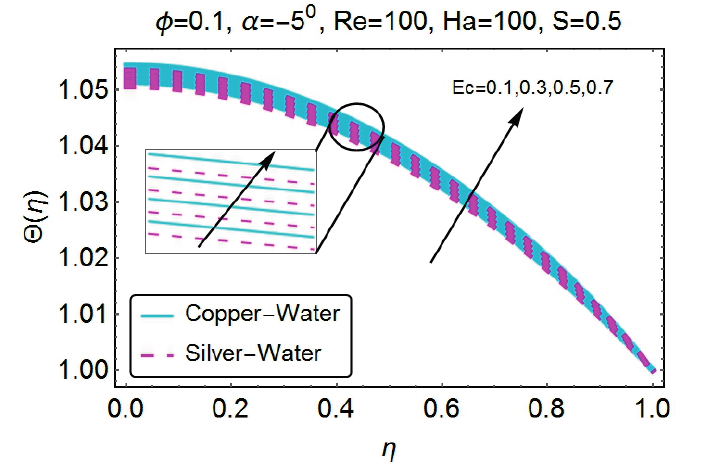
Figure 26. Change in temperature for varying Ec (convergent channel/stretching case).